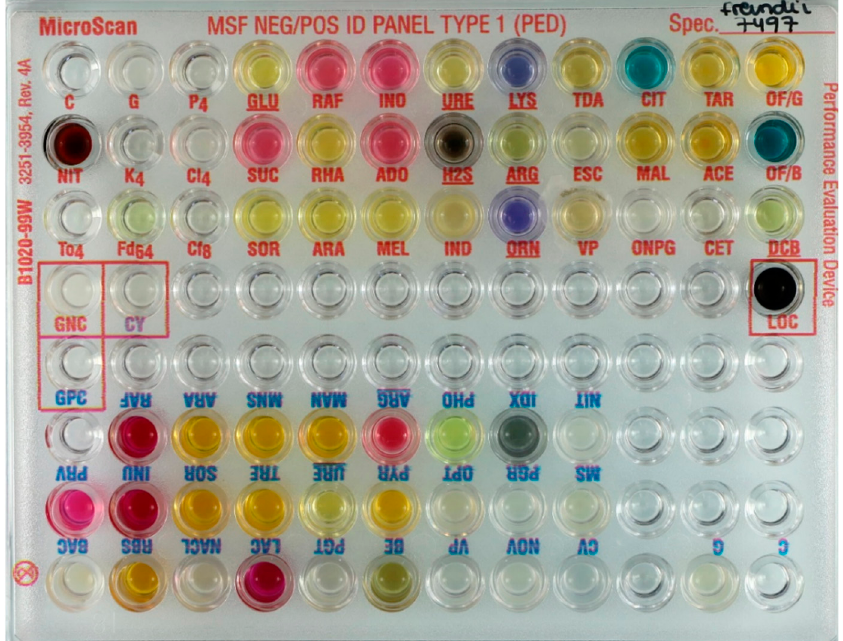
Figure 1. Example of an inoculated customized M é decins Sans Fronti è res (MSF) ID panel (MSFN- PID1): Gram-negative test wells on the top side and Gram-positive test wells on the opposite side. Gram-positive and Gram-negative test panels can thus be inoculated simultaneously; for reading, one of the two sides must be